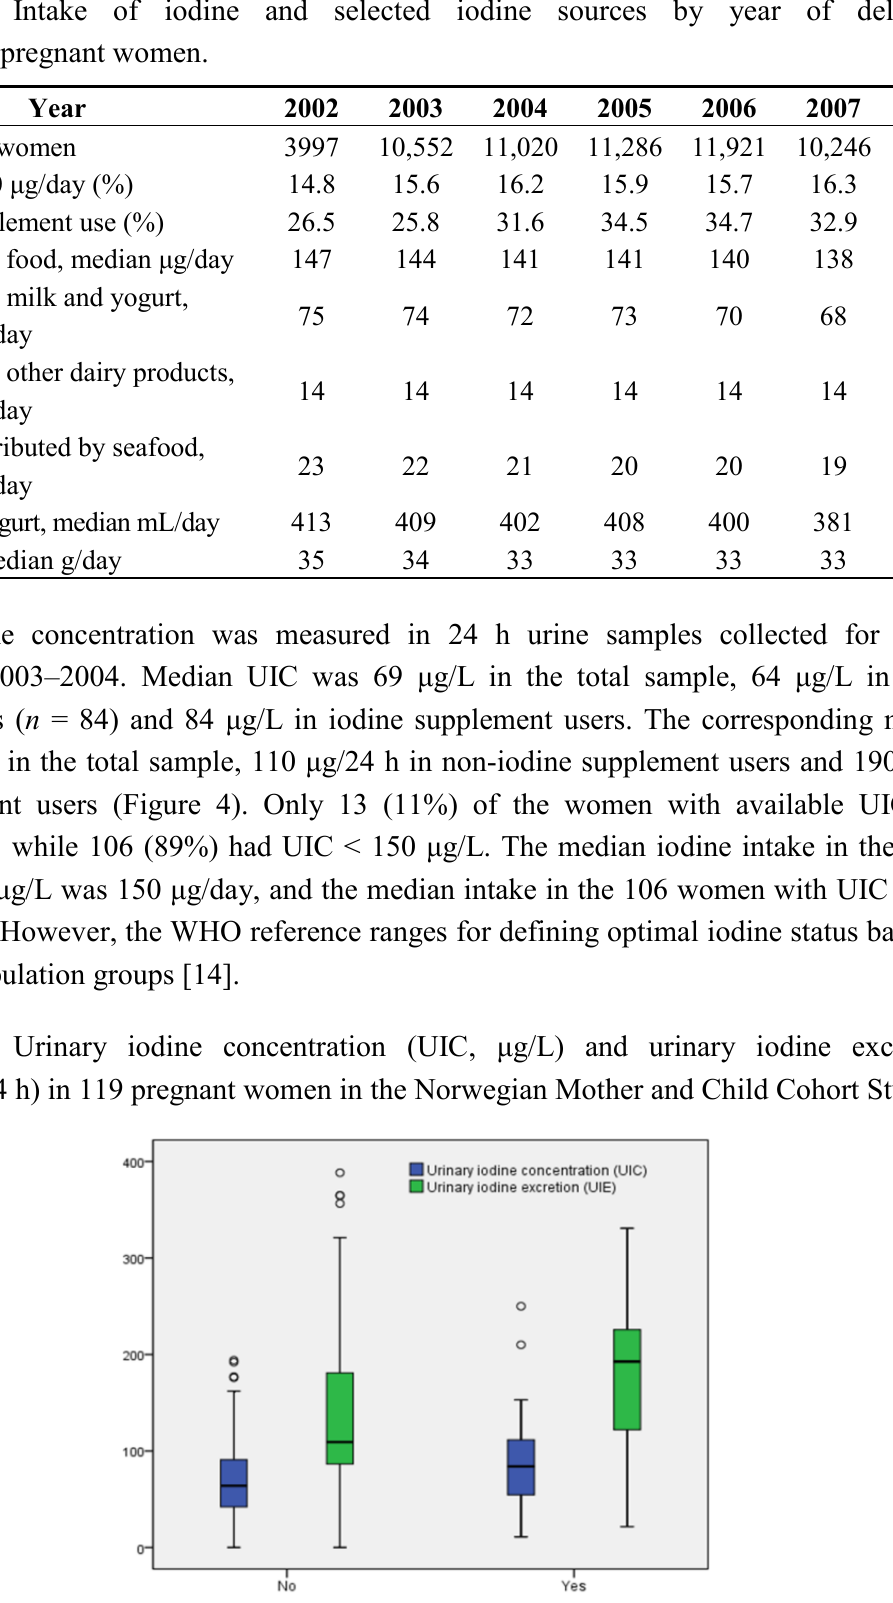
Box plot details: the horizontal line indicates the median; the box indicates the interquartile range (IQR) (IQR: 25th percentile to 75th percentile); the whiskers represent observations within 1.5-times the IQR; and the circles indicate observations more than 1.5-times the IQR away from the box, considered as